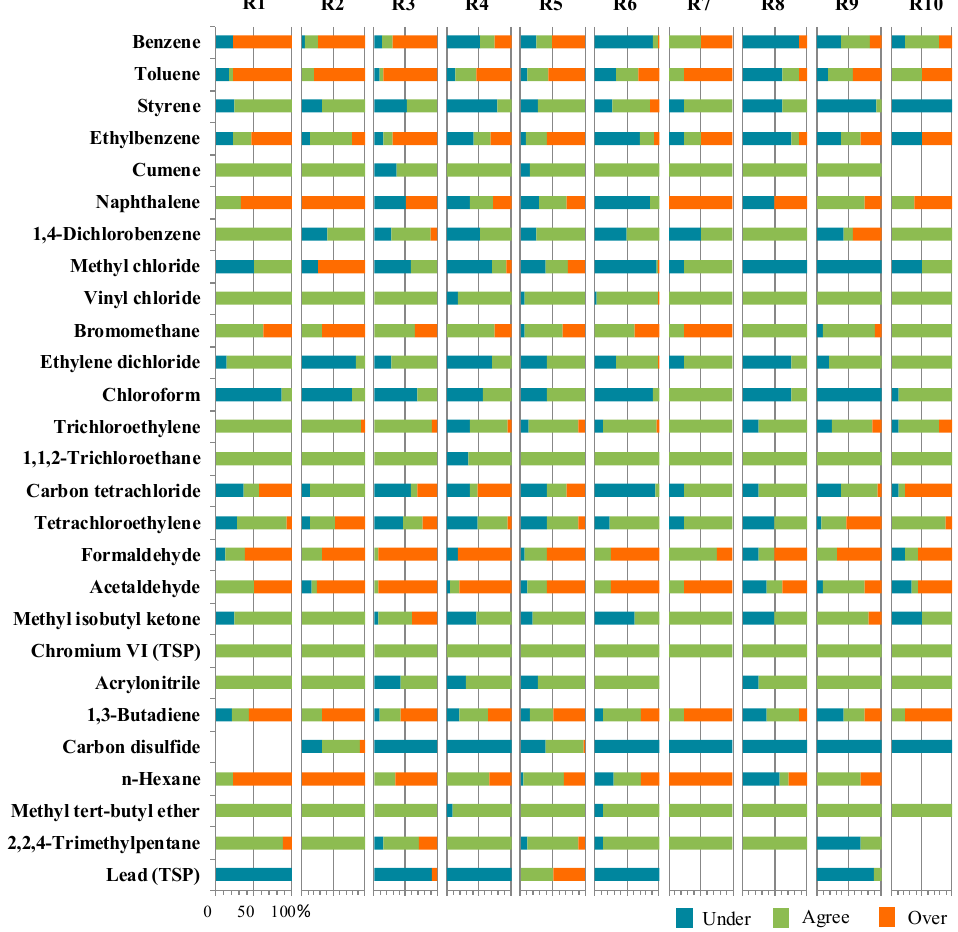
Figure 2. Percentages of agreement, underestimation, and overestimation sites by EPA region. Notes: R—EPA region; Under—underestimation; Agree—agreement;